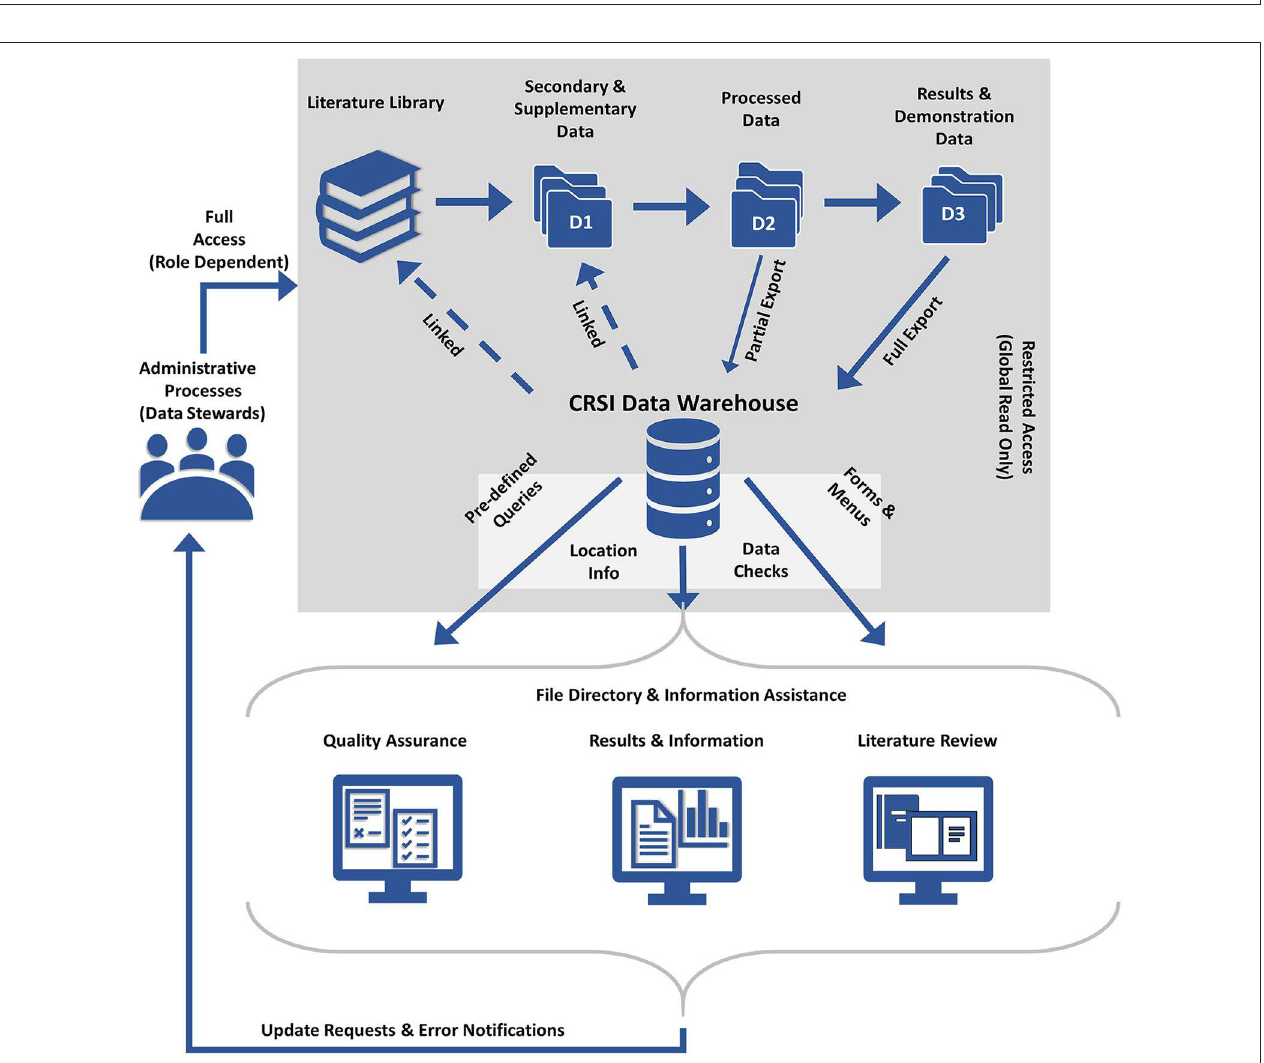
Frontiers in Environmental Science |